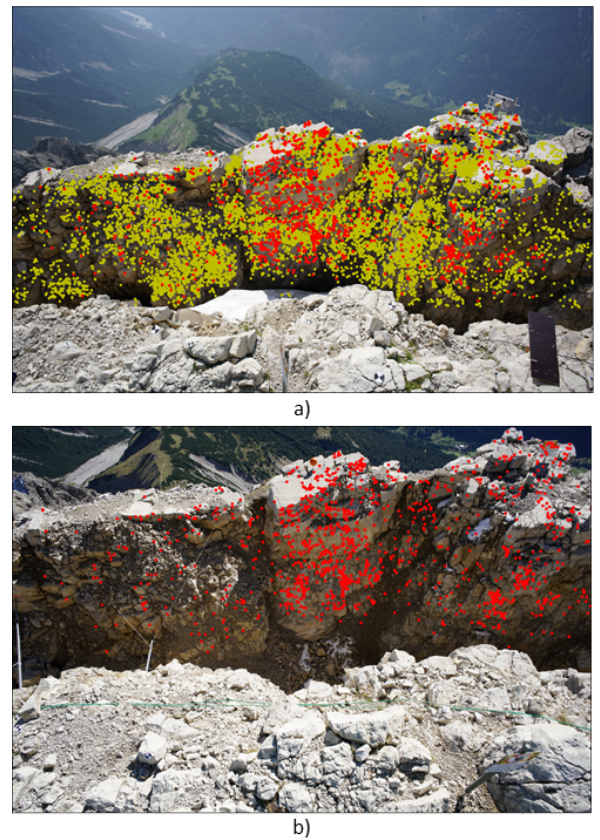
Figure 4. Calculated point correspondences between epochs. a) The yellow dots mark all potential key points of the 2021 epoch. The red dots mark the key points detected between epochs. b) Matched key points in an image of 2018